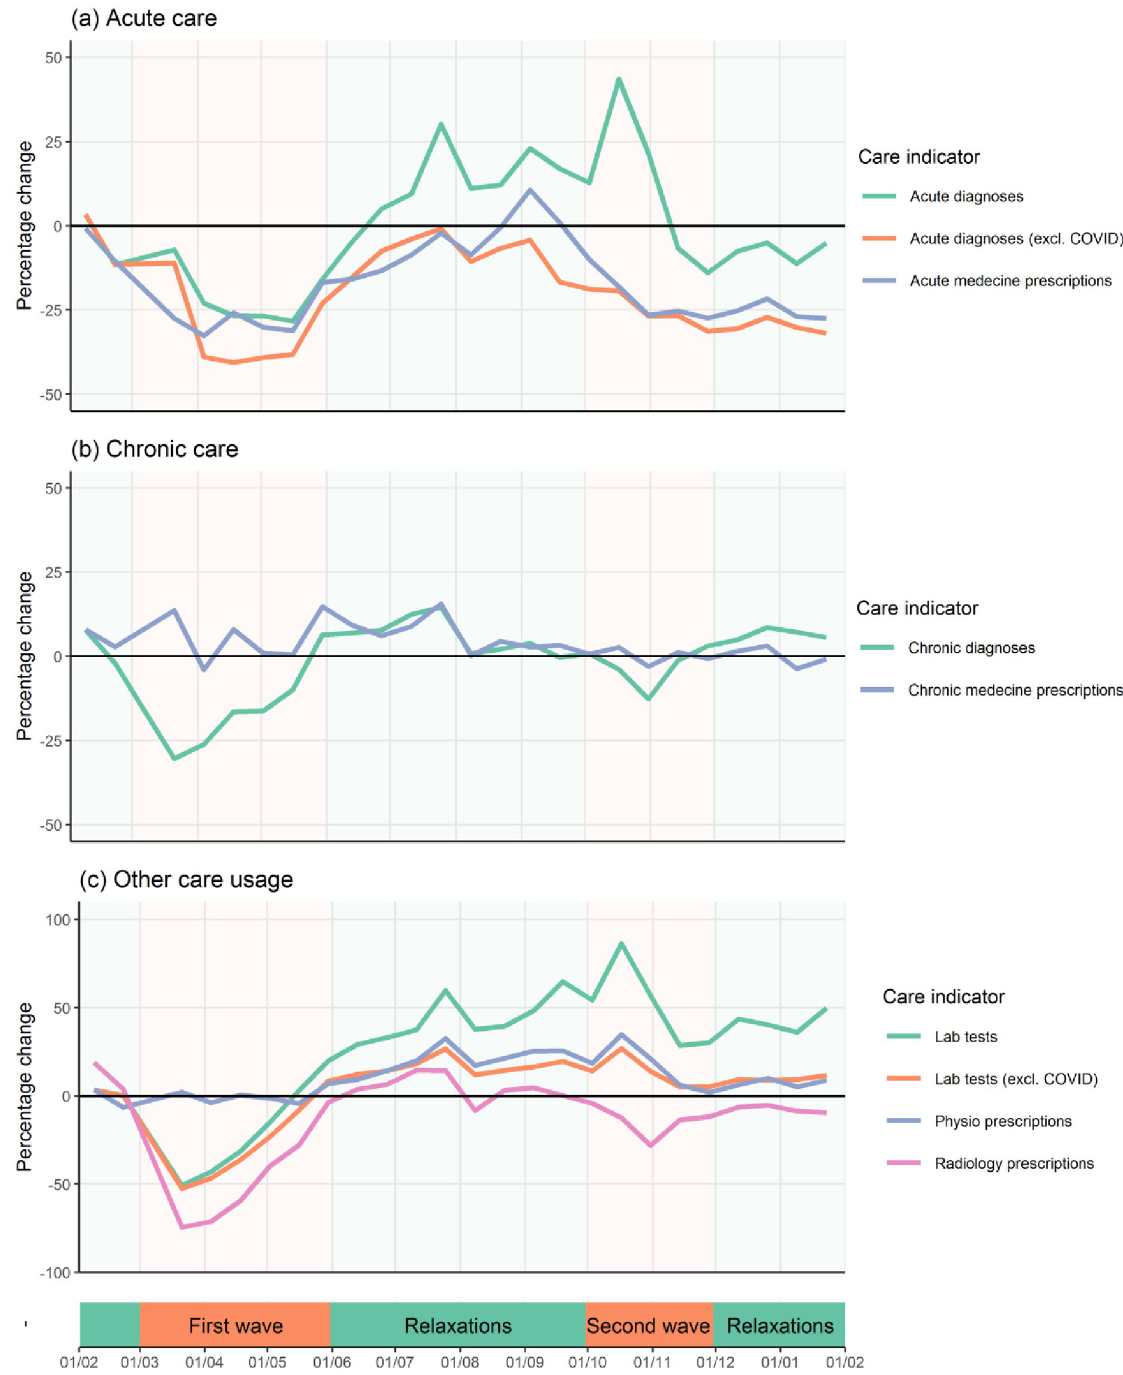
Fig 1. Evolution of care provision for various care indicators in the first year of the Covid-19 pandemic (February 1, 2020–January 31, 2021) relative to the two previous years.